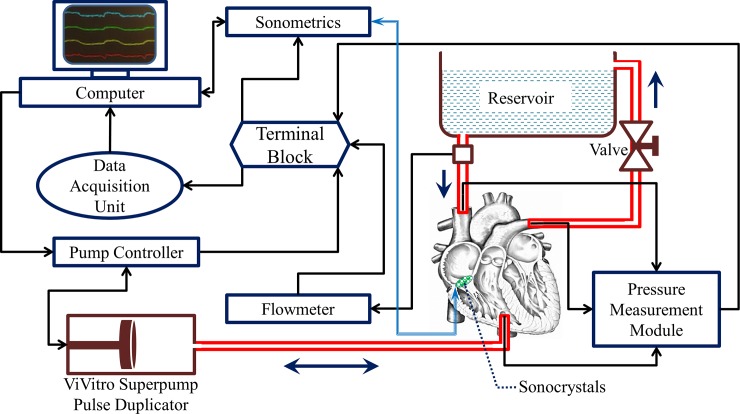
Schematic of the ex-vivo heart apparatus [24].